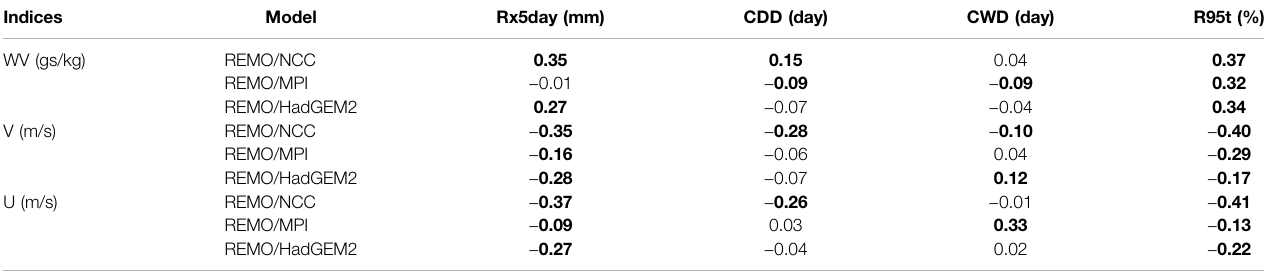
TABLE3| Correlationcoef fi cientsbetweenthechangesintheextremeindicesandthechangesinthewatervapor fl uxandthewindfromthethreedownscalingsimulations. Indices